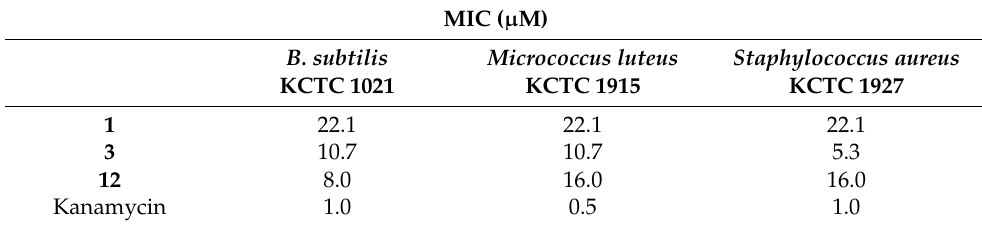
Table 3. Antibacterial activities of 1 , 3 , and 12 .